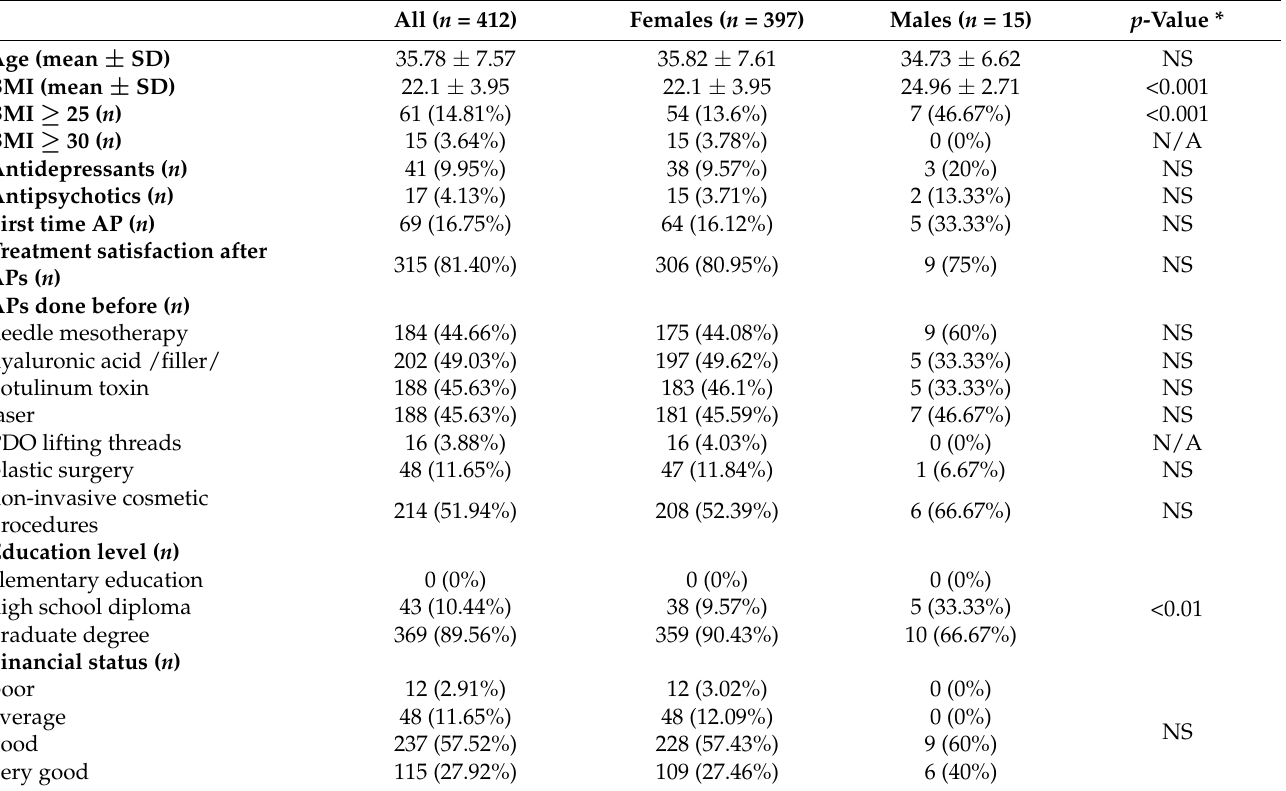
Table 1. Characteristics of the studied group undergoing aesthetic dermatology